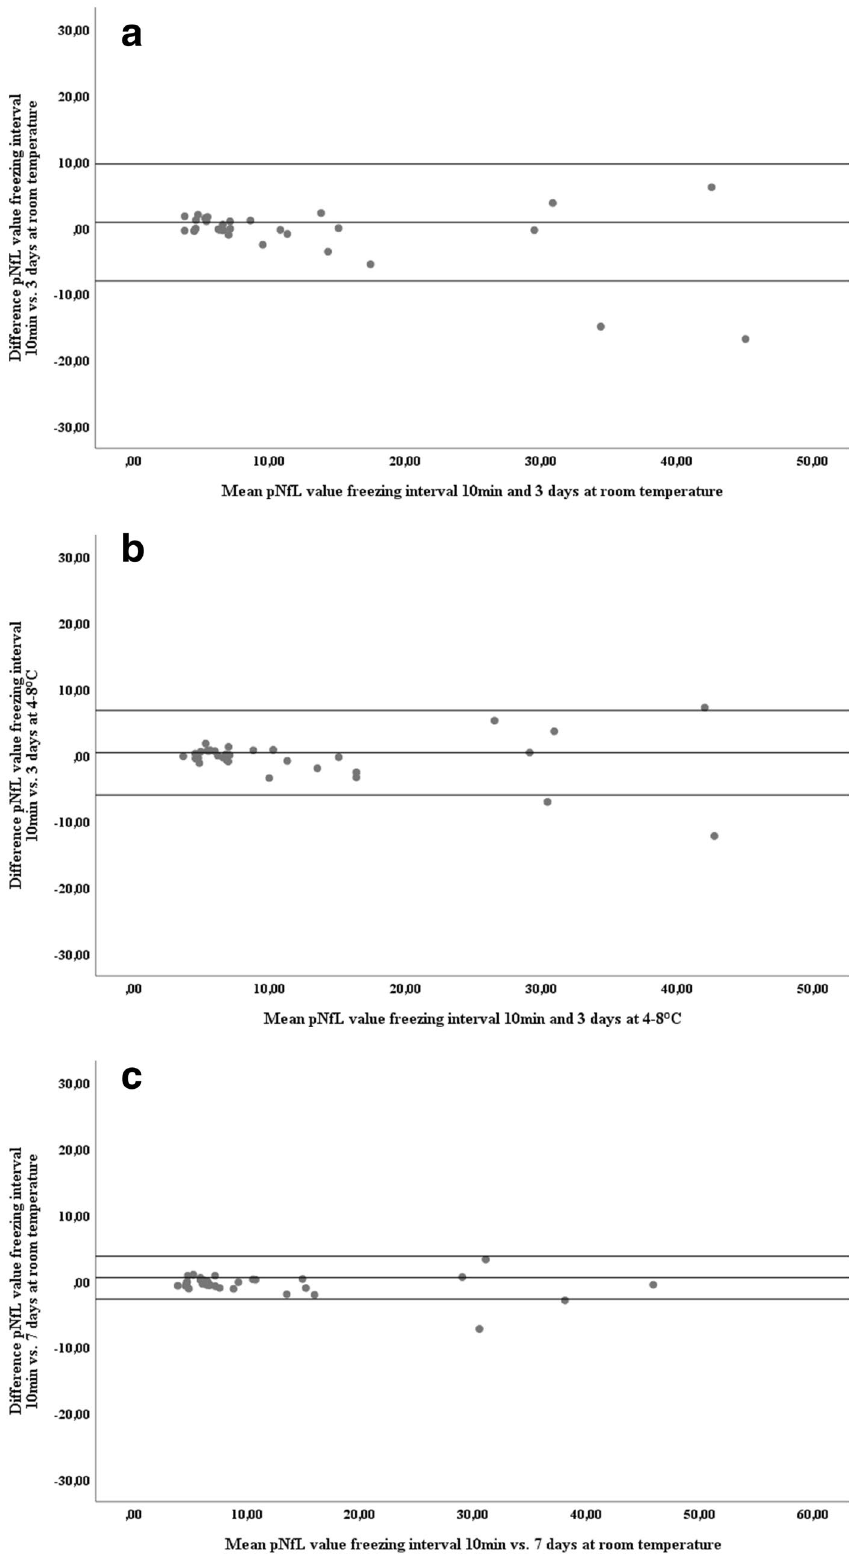
Figure 2. Differences in pNfL concentrations after different freezing intervals. Bland–Altman plot showing the differences in sNfL concentration between two groups of immediate processing and delayed freezing, ( a ) freezing after 10 min compared to 3 days at room temperature, ( b ) freezing after 10 min compared to 3 days at 4–8 °C, ( c ) freezing after 10 min compared to 7 days at room temperature. Single dots represent samples at two conditions with their mean concentrations on the x-axis and their difference in concentration on the y-axis. The three horizontal lines represent the mean difference (middle) and the mean difference plus 1.96xSD of that difference (upper) and mean difference minus 1.96xSD of that difference